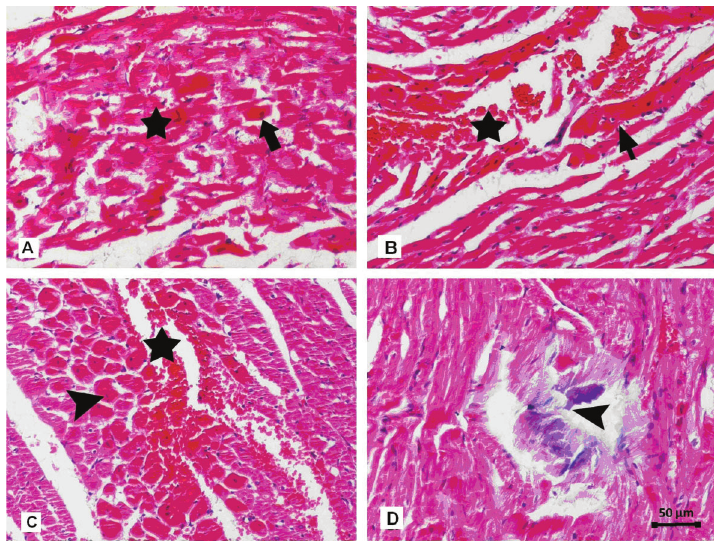
Figure 1. Histopathological evaluation of heart tissues. A , Degeneration and severe necrosis (thick arrow) of cardiac muscle with abundant karyopyknosis in Cont group. B , Longitudinal view of cardiac fibers, separated heart muscle due to excessive bleeding (star) and necrotic myofibers (arrow) in Cont group. C , Transverse view of cardiac muscle with dense eosinophilic cytoplasm and pyknotic nuclei (arrowhead) and excessive bleeding between the muscle fibers in Cont++MP group. D , Calcification area (arrow- head) surrounded with degenerative and necro- tic myofibers in Cont++QC group. Cont: cardiac contusion; Cont++MP: Cont group treated with methylprednisolone; Cont++QC: Cont group treated with quercetin. Hematoxylin and eosin staining, 20 6